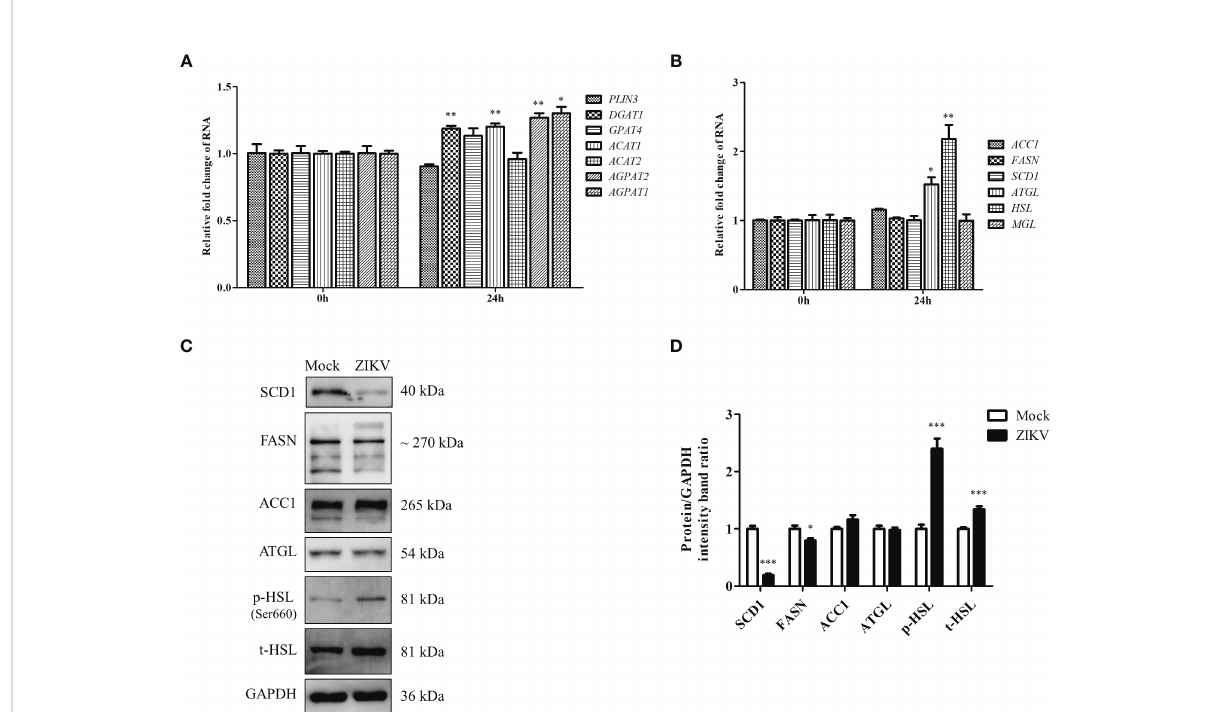
FIGURE 2 ZIKV infection promotes LD biogenesis and expression of lipolysis-related HSL gene in Huh7 cells. (A – C) Huh7 cells were infected with ZIKV at an MOI of 0.5 or mock-treated for 24 h. Samples were collected and subjected to qRT-PCR (A, B) or western blot analysis (C) . The mRNA levels of genes related to LD biogenesis (A) , lipid synthesis, or lipolysis (B) were determined. (C) Western blot analysis of SCD1, FASN, ACC1, ATGL, and HSL levels. GAPDH was used as a loading control. Representative images are presented. (D) The intensity band ratios of SCD1, FASN, ACC1, ATGL, p-HSL, and t-HSL to GAPDH were measured using densitometry. Data are presented as the mean ± SD from triplicate. * p < 0.05, ** p < 0.01, *** p <